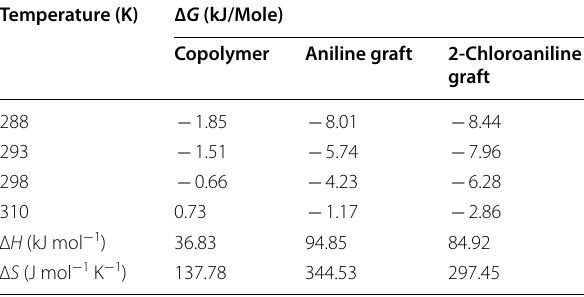
Table 4 Thermodynamic parameters Temperature